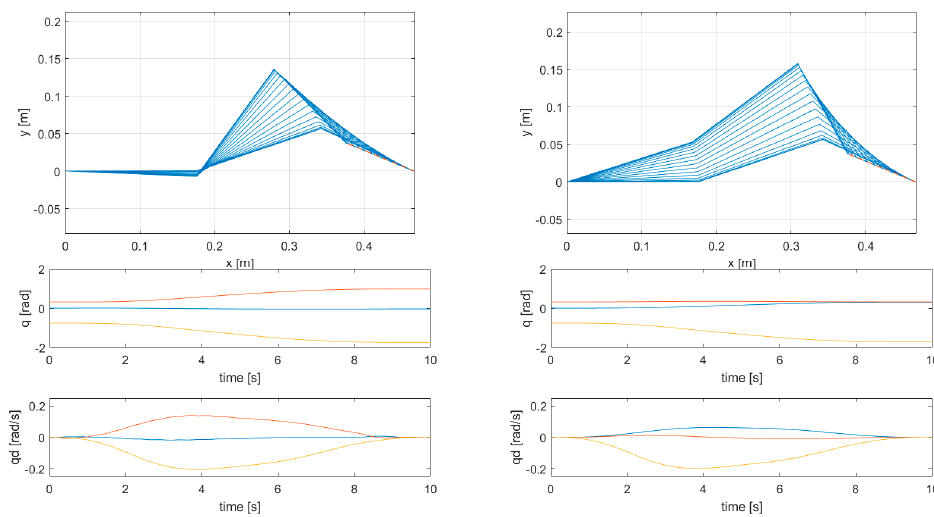
Figure 4. Trajectory 1, comparison between PMKE ( left ) and LSV ( right ). First joint: blue lines; second joint: red lines; third joint: yellow lines.